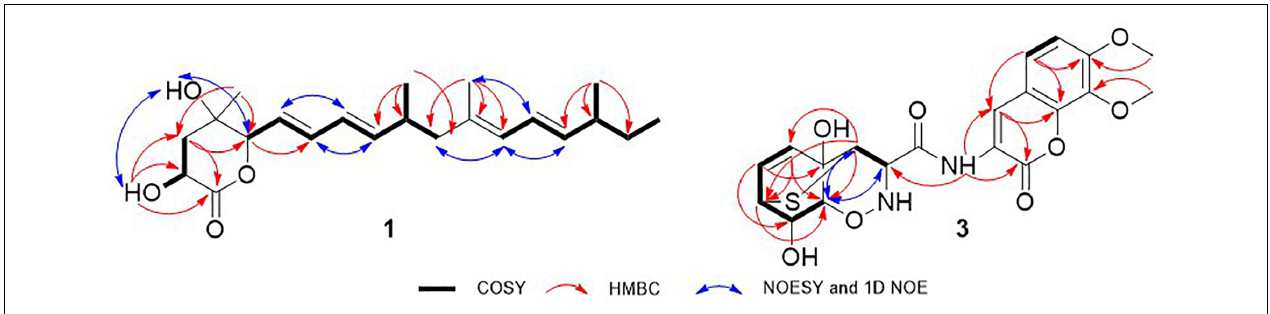
FIGURE 2 | COSY, key HMBC, 1D NOE, and NOESY correlations of 1 and 3 .